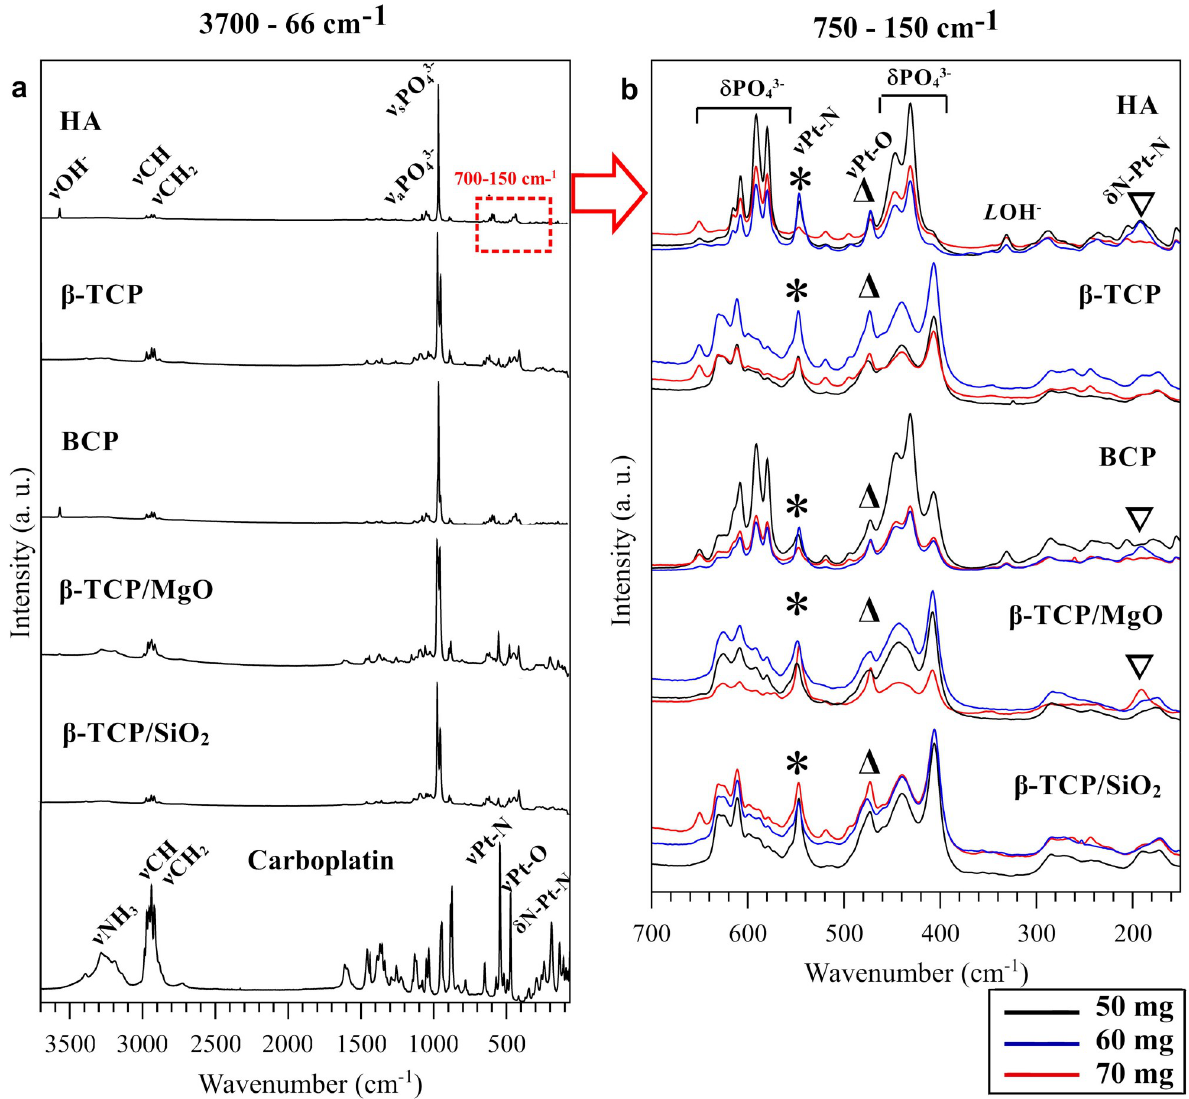
Fig 6. Raman spectroscopy of the granulated calcium phosphate-carboplatin biomaterials and carboplatin drug alone (carboplatin and mannitol). (a) High-intensity phosphate peaks of calcium phosphate biomaterials and carboplatin-drug detected peaks in the 70 mg/g concentration biomaterials; (b) 700–150 cm -1 graphs with calcium phosphate peaks and characteristics platinum vibrational modes of carboplatin in 50 mg/g (black line), 60 mg/g (blue line) and 70 mg/g (red line) biomaterials.